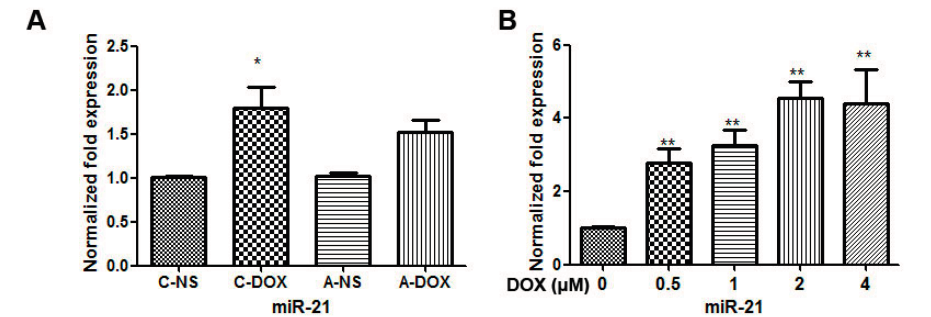
Figure 2. The effects of DOX on the expression of miR-21 in myocardium and H9C2 cells. ( A ) The expression of miR-21 in myocardium. * , p < 0.05, compared to that in C-NS group, n = 3; Note: C-DOX: Chronic DOX injury group; C-NS: Chronic normal saline control group; A-DOX: Acute DOX injury group; A-NS: Acute normal saline control group; and ( B ) The expression of miR-21 in H9C2 cells treated with various doses (0–4 µM) of DOX